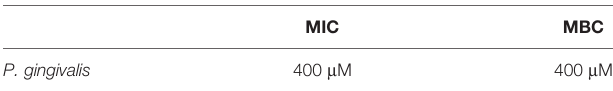
TABLE 2 | The MIC and MBC of ginsenoside